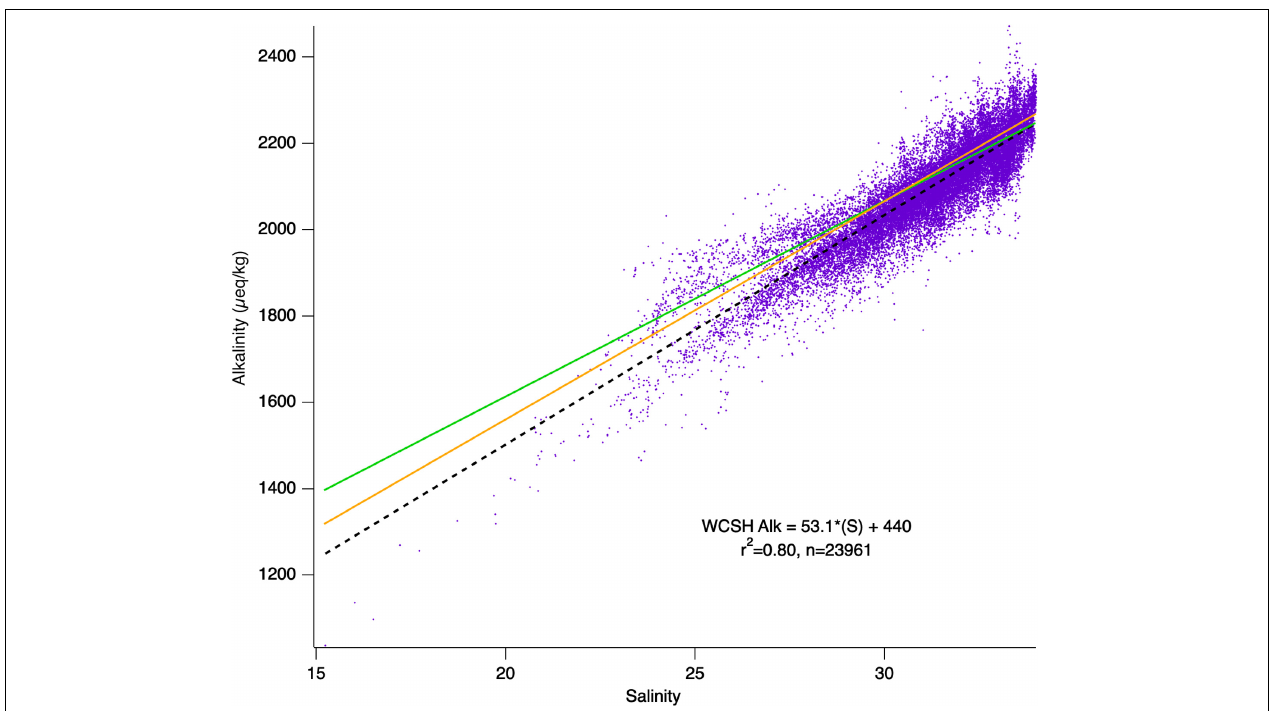
FIGURE 7 | Composite alkalinity-salinity regression for all years 2014–2019 and associated correlation statistics. Purple dots represent hourly calculated alkalinity data and black dashed line represents a simple linear-fit. Published regional alkalinity-salinity relationships from from Cullison Gray et al. (2011; orange), and Takahashi et al. (2014; green) are